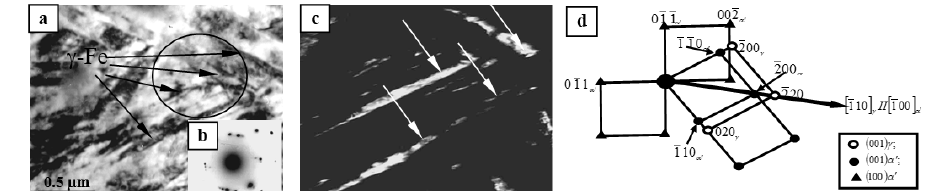
Figure 2. Interlayers of residual austenite ( γ -phase) along the boundaries of martensitic battens in R6M5 steel in the initial state ( a )—bright-field image; ( b )—microdiffraction pattern; ( c )—dark-field image obtained in the reflex [020] γ ; ( d )—the indicated microdiffraction pattern.